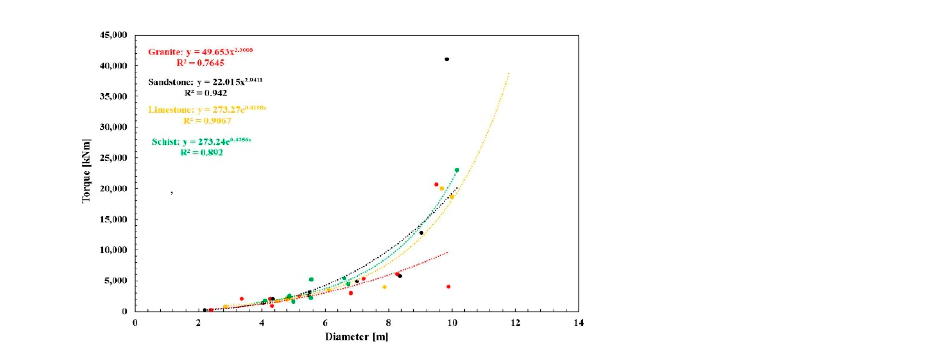
Figure 18. Correlation between the diameter and the torque due to the excavation in granite, sandstone, limestone, and schist by double shield TBMs.